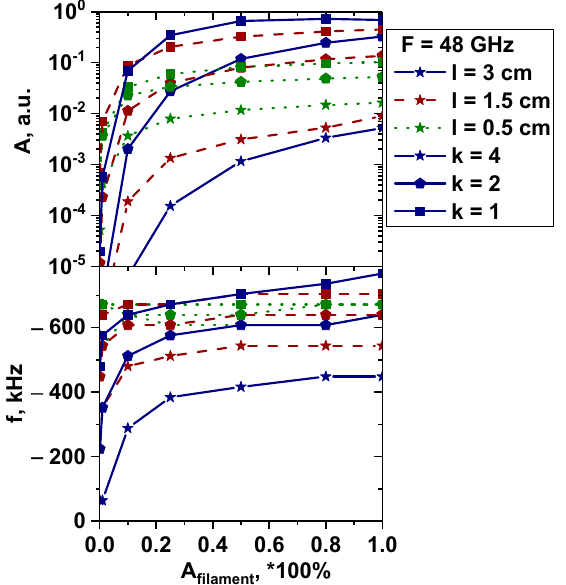
Figure 32. For the poloidally stretched filament with an amplitude of 50%: ( left ) dependency of the DBS signal amplitude (bold lines with scale on the left) and frequency (lines with pentagon shapes with scale on the right) on the probing frequency; ( right ) dependency of the calculated velocity on the probing frequency. The navy-blue lines are the circular filament with a 3 cm diameter, the wine-red are that of 1.5 cm, and the olive-green are that of 0.5 cm. The black vertical lines indicate the probing frequencies available in Globus-M2, and the vertical orange dashed line indicates the position of the filament at cutoff of the 48 GHz probing wave. The horizontal line marks the set 10 km/s filament velocity.